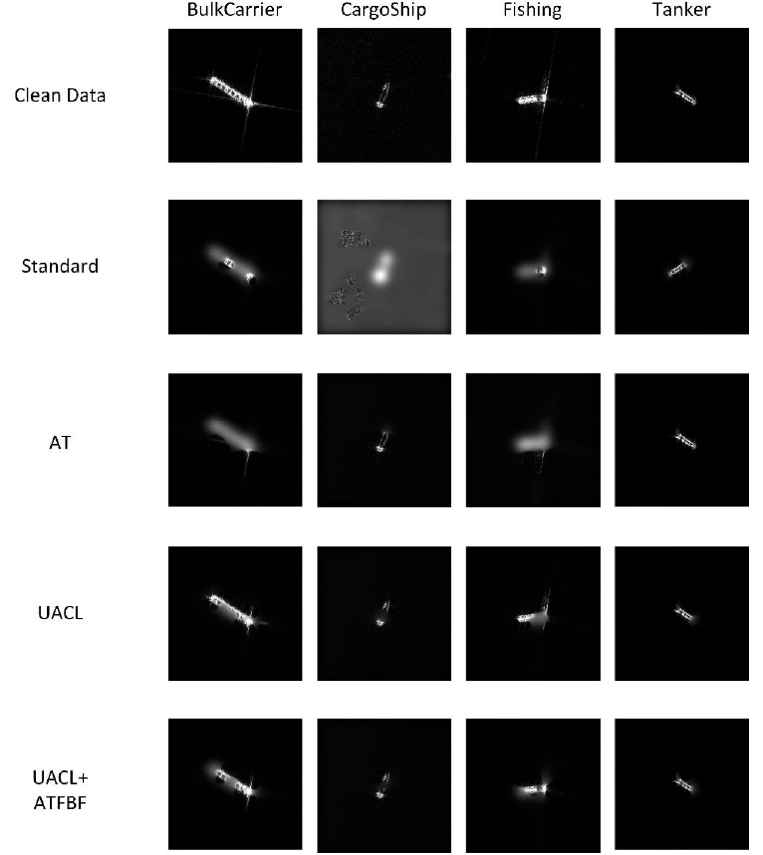
Figure 15. Extremal perturbations images of FUSAR-Ship model in the classification of clean data.